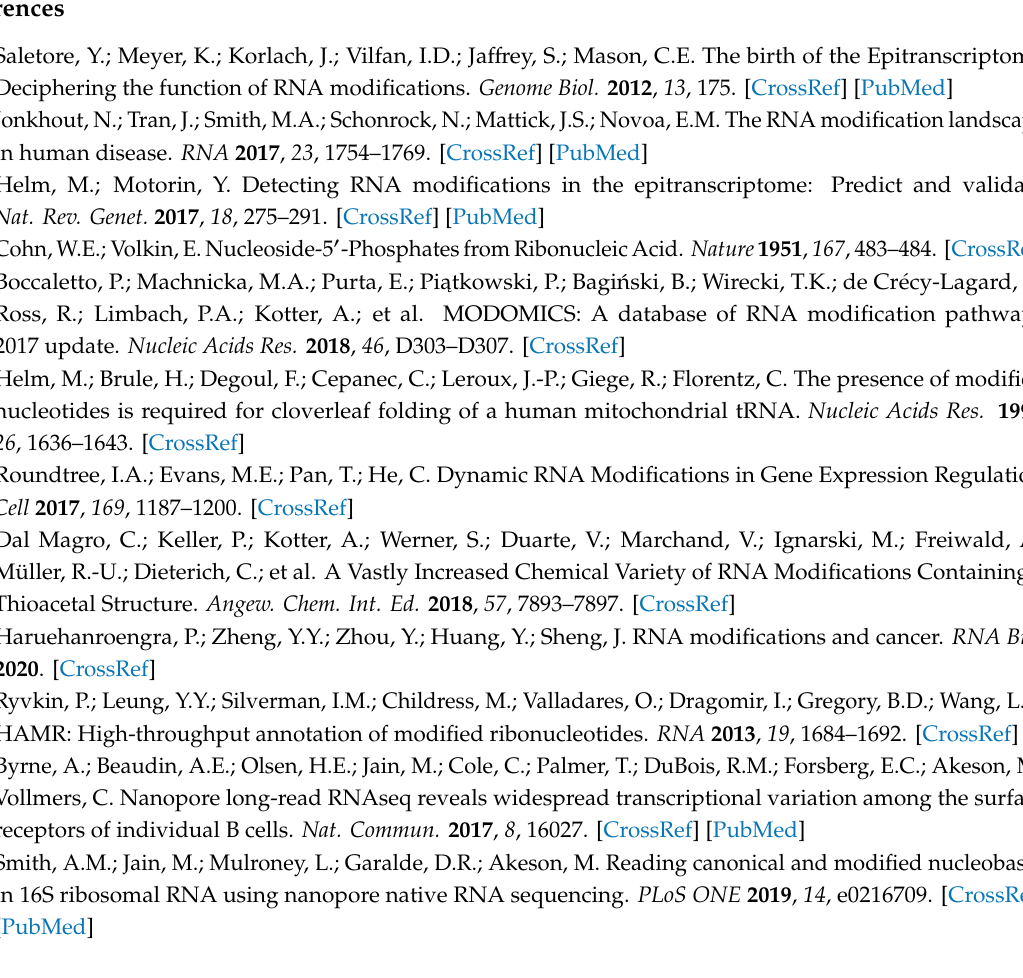
Figure S1: Graphical overview of modification profile extraction. Figure S2: Exemplary alteration of m 1 A signatures. Figure S3: RT signature alteration of m 1 G and m 3 C. Figure S4: Manganese influence of mismatch composition on modification